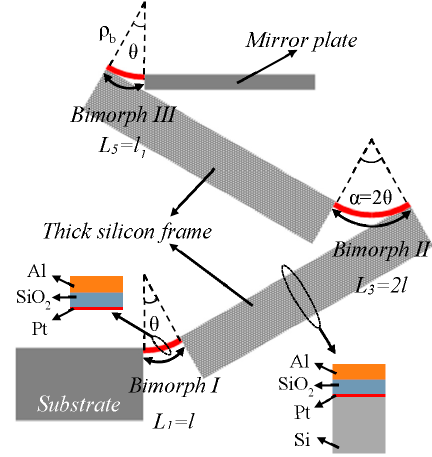
Figure 1. Schematic of the Al/SiO 2 -based lateral-shift-free design, with thick silicon as